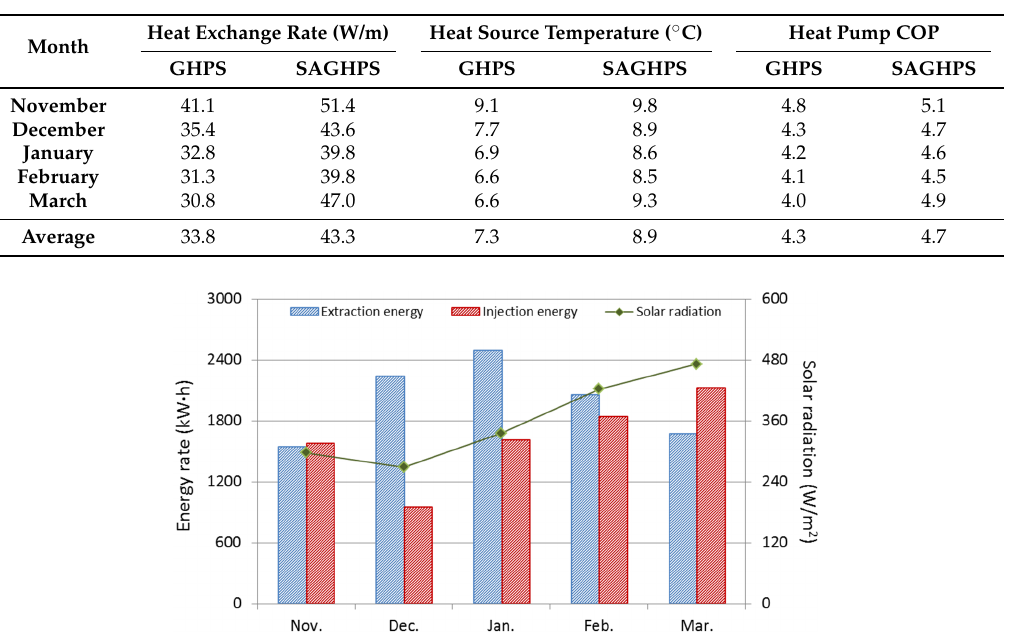
Figure 8. The heat source temperature in different systems. Table 2. Simulation results.